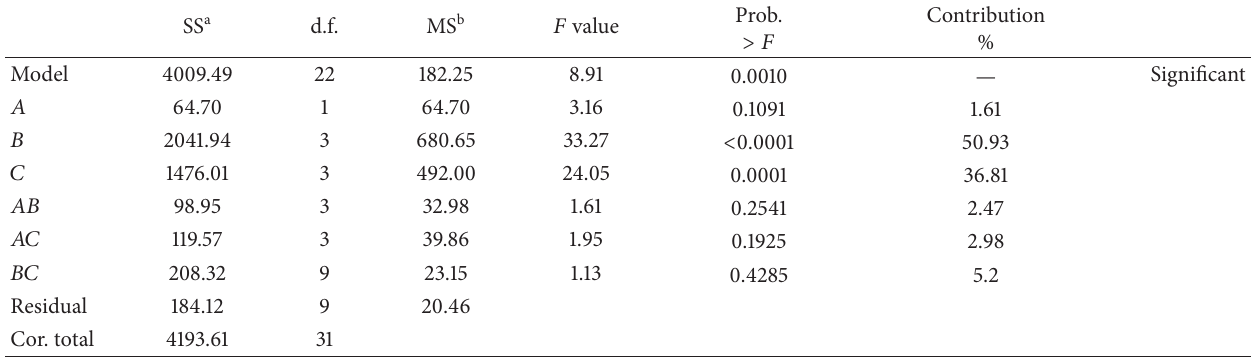
Table 5: ANOVA for P(3HB- co -4HB)/collagen blend